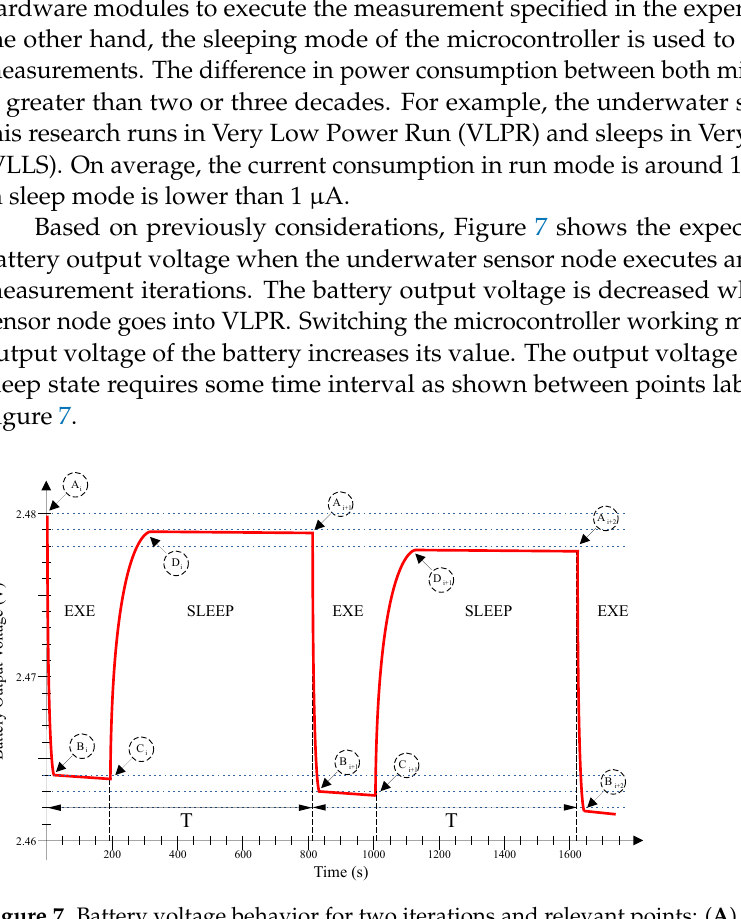
Figure 7. Battery voltage behavior for two iterations and relevant points: ( A ) Starting the Execution step. ( B ) Voltage stabilization for the Execution step. ( C ) Recovery phase. ( D ) Dropping phase sleeping till the next wake